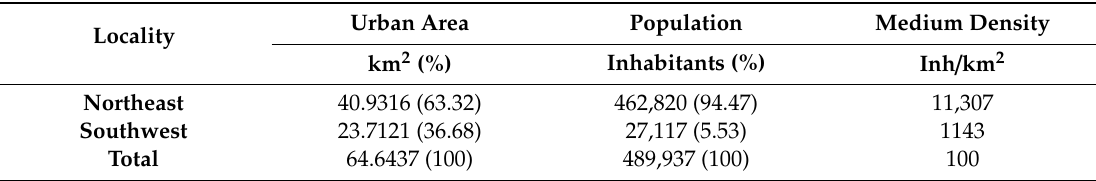
Table 3. Distribution of urban population in Atizap á n de Zaragoza (elaborated by the authors, with data from INEGI 2015)